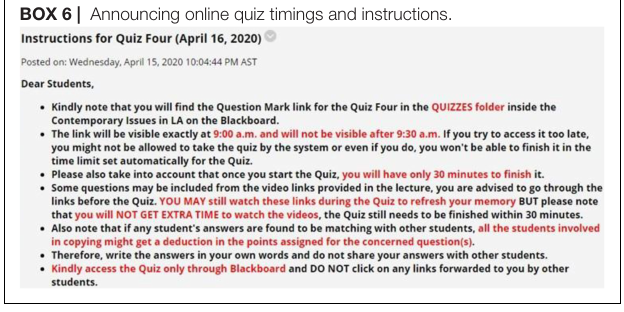
BOX 7 | Added details and instructions for online